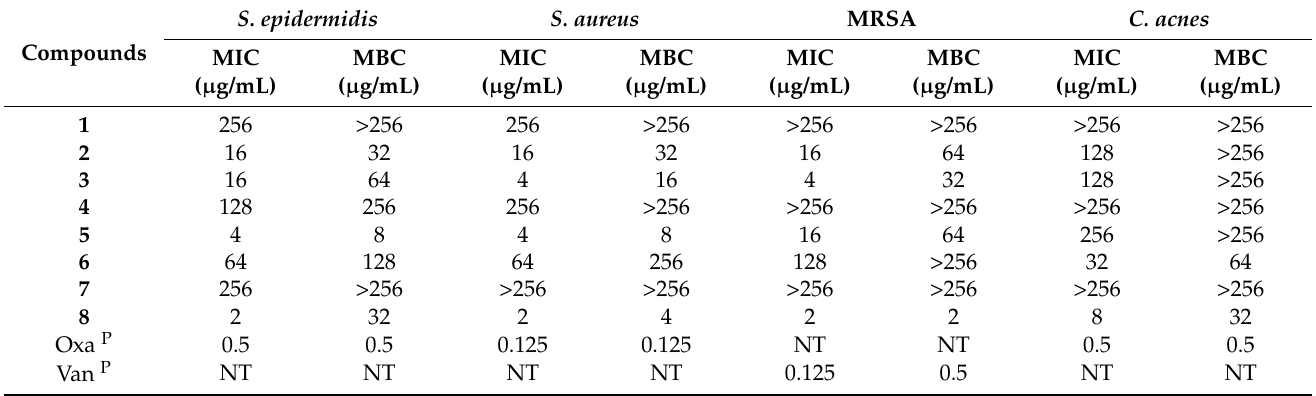
Table 2. MIC and MBC of isolated compounds against S. epidermidis , S. aureus , MRSA, and C. acnes .